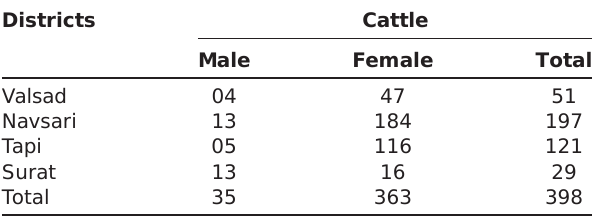
Table-3: Details of districts and sex-wise sample collection in cattle. Districts Cattle